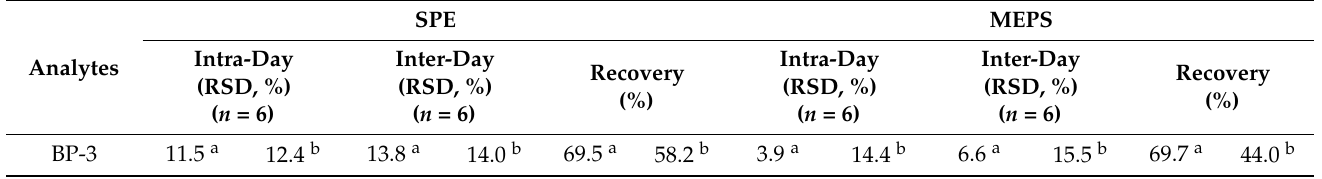
Table 3. Precision and accuracy of the SPE and MEPS methods obtained in determination of BP-3 in cosmetics samples. SPE Analytes